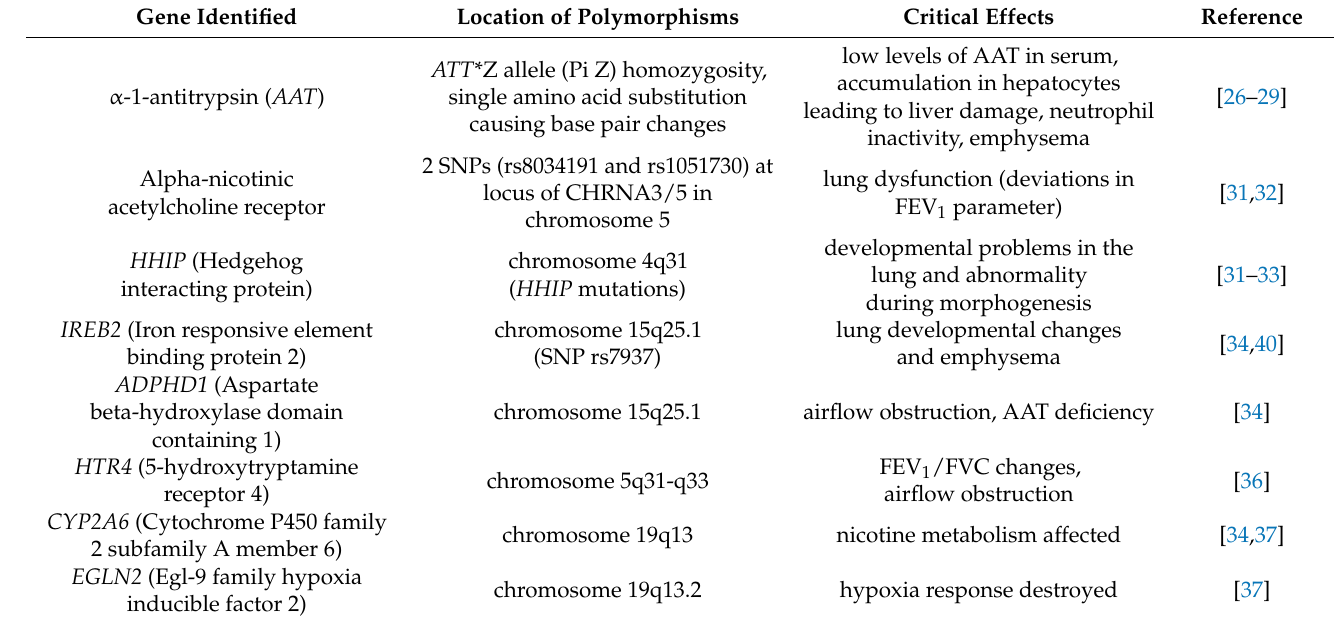
Table 1. Gene polymorphisms in